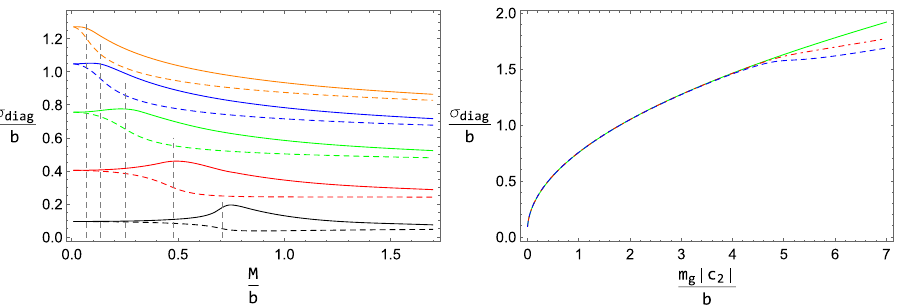
Fig. 5 Left: the transverse (solid lines) and longitudinal (dashed lines) conductivities as a function of M / b for different graviton mass at T / b = 0 . 03. The plot is for m g | c 2 | / b = 0 (black), 0 . 25 (red), 1 (green), 2 (blue), 3 (orange). The dashed gray lines are the location of critical